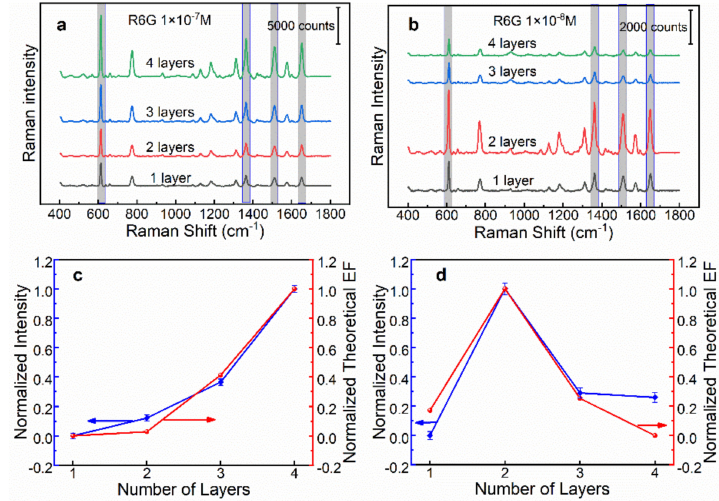
Figure 4. ( a ) The SERS spectra of 1 × 10 − 7 M R6G collected on the n -AgNP@glass substrate ( n = 1, 2, 3, 4). ( b ) The SERS spectra of 1 × 10 − 8 M R6G collected on the n -AgNP@Au film substrate ( n = 1, 2, 3, 4). ( c , d ) The variation of normalized SERS intensity at 612 cm − 1 and normalized theoretical enhancement factor with the layer number of AgNPs on glass and Au film supports,